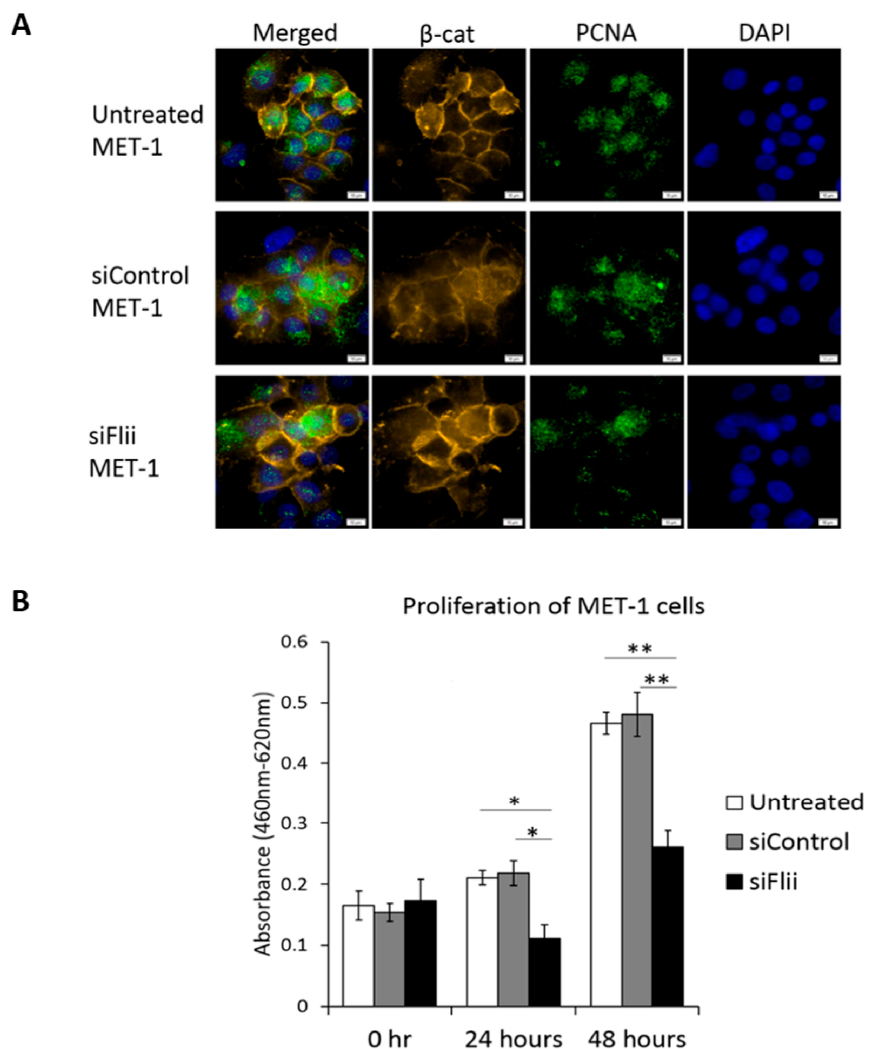
Figure 3. Knockdown of Flii in human cSCC cell line leads to decreased cell proliferation independent of β -catenin. ( A ) Immunocytochemistry of β -catenin (yellow), PCNA (green) and DAPI (blue) in MET-1 cells following Flii knockdown showing no effect on β -catenin and reduced expression of PCNA. Scale bars, 5 μ m. ( B ) Quantification of WST-1 proliferation assay following Flii knockdown in MET-1 cells at 24 and 48 h showing significant reduction in cell proliferation. Mean ± SEM. n = 6. * p < 0.05, ** p < 0.005.